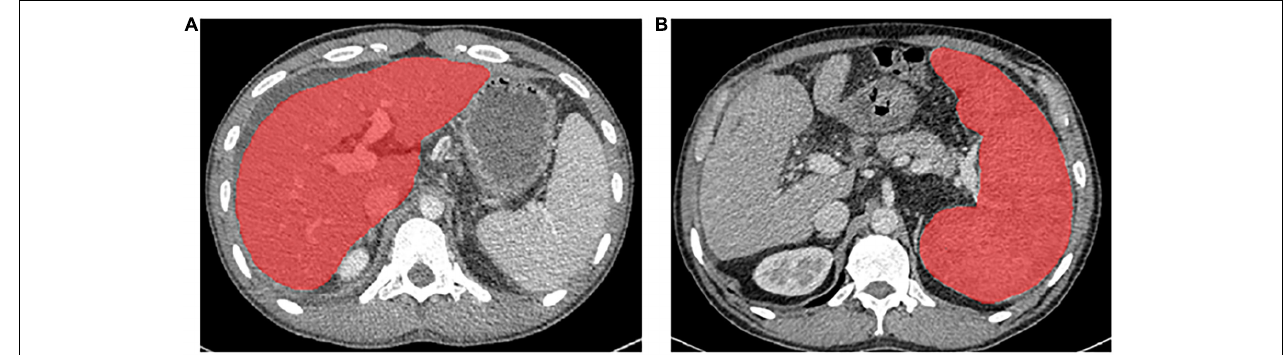
FIGURE 2 | The delineation of the region of interest of the liver (A) and spleen (B) on CT images.